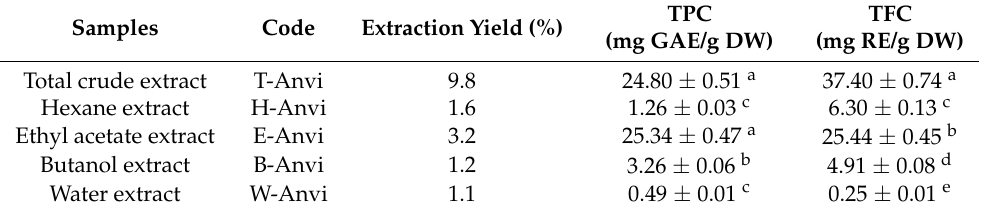
Table 1. Extraction yield and total phenolic (TPC) and flavonoid (TFC) contents. Samples